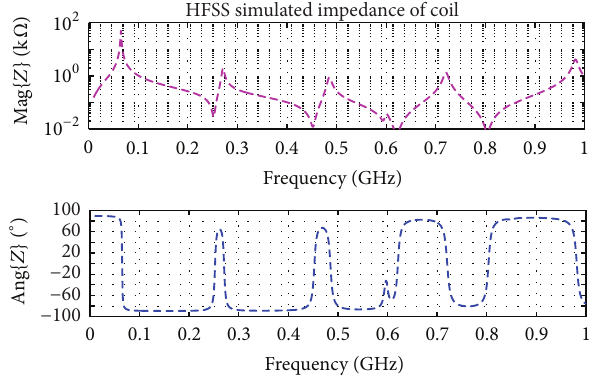
Figure 3: Coil impedance versus